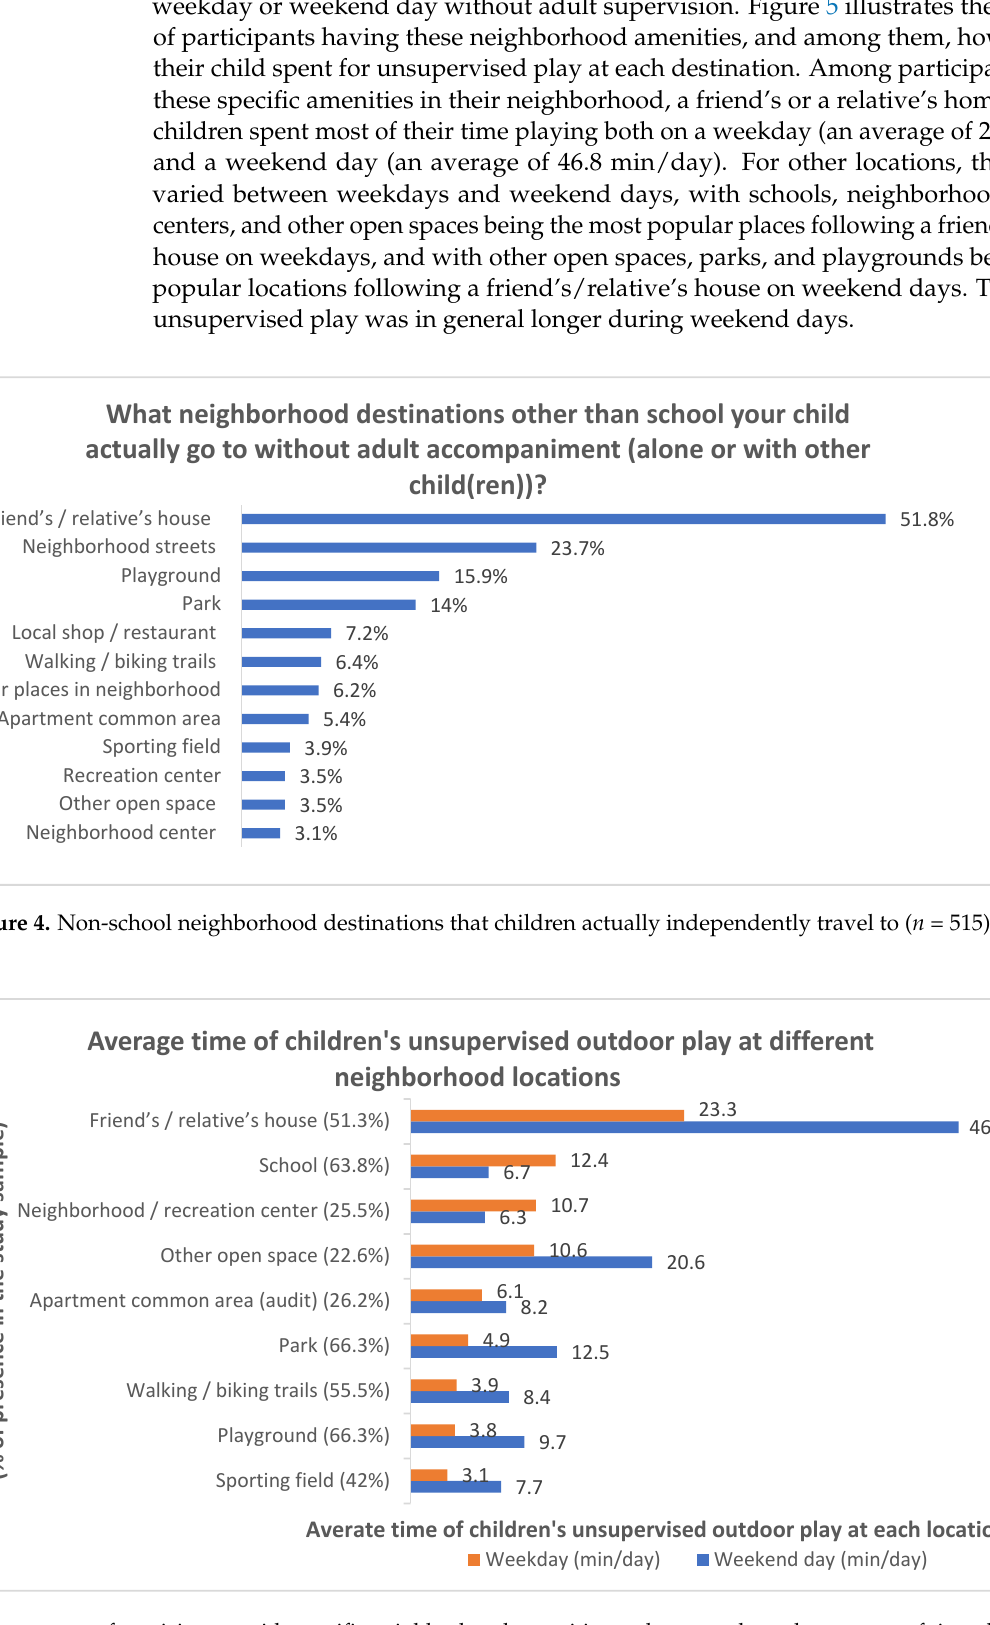
Figure 5. Percentages of participants with specific neighborhood amenities and among them the amount of time their child spent for unsupervised play at each location.